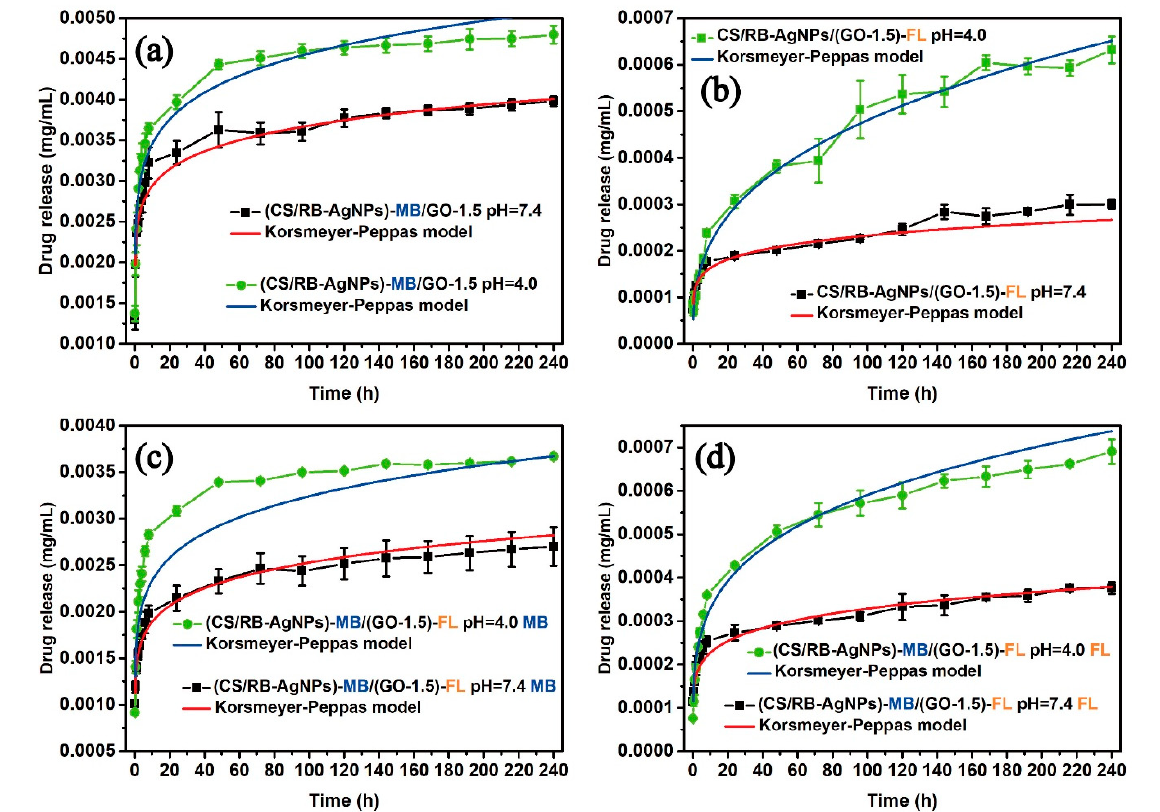
Figure 6. Fitting of single and dual drug release curves to the Korsmeyer–Peppas model (solid lines). The curve fitting values for D K , N and, the corresponding R 2 values can be found in Table 2. Table 2. The kinetic parameters in Korsmeyer–Peppas models.